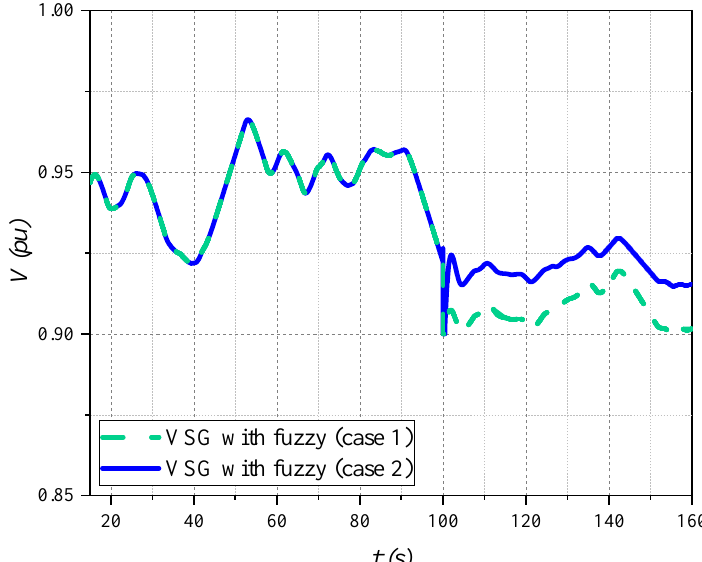
Figure 28. Voltage response of the system for the scenarios presented in Section 4.2.